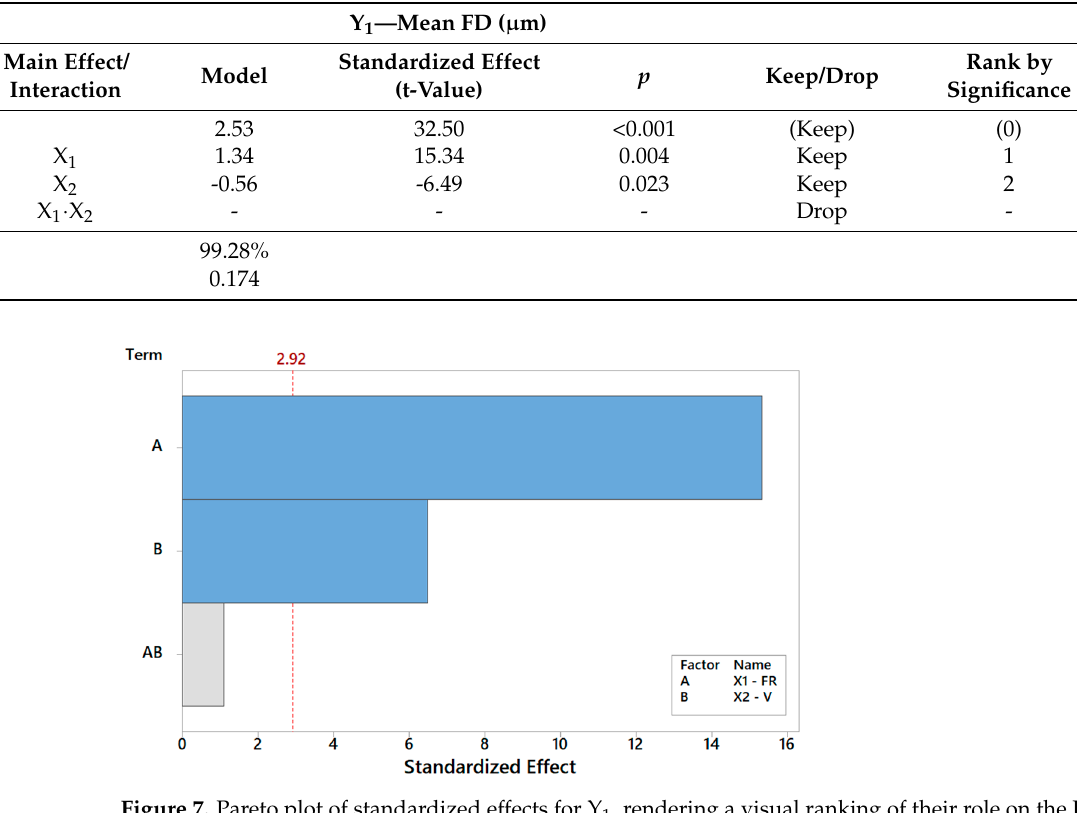
Figure 8. The main effects plot for the FD plot showing how the model explains the change in mean FD based on the change of the FR and V levels .